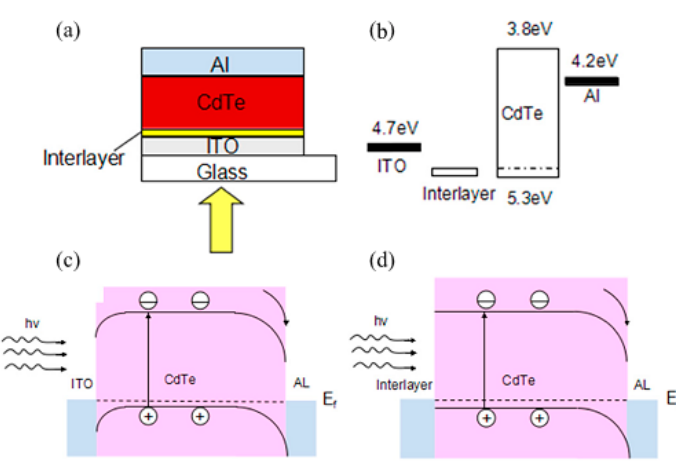
Figure 2. A schematic image of the CdTe nanocrystals (NCs) solar cells: ( a ) the device’s structure; ( b ) the energy diagram; ( c ) the band diagram without an interlayer; and ( d ) the band diagram with an interlayer. Reproduced with permission from [36]. Copyright 2014, IOP Publishing.